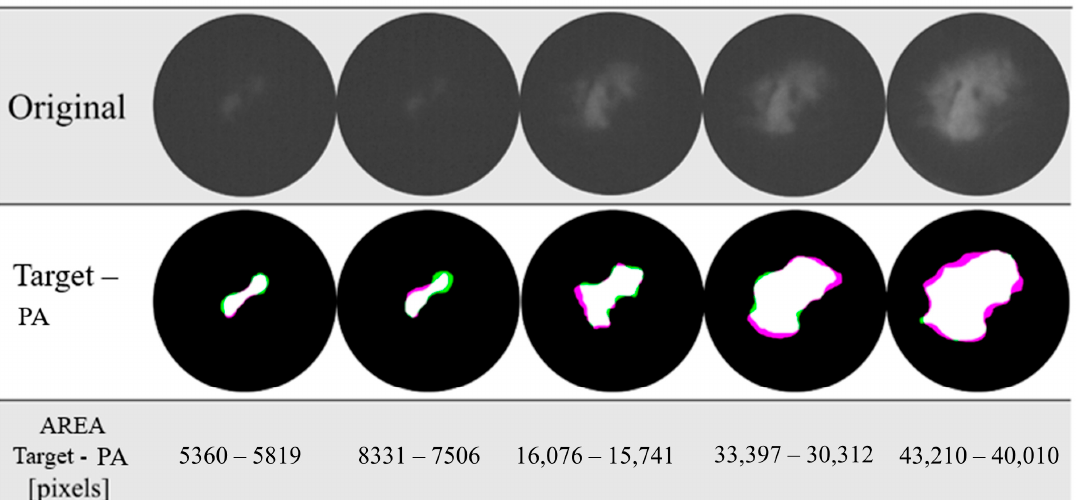
Figure 9. Overlap of the binarized Target images and CNN ones and quantification of the corre- sponding equivalent flame area. The overestimation is indicated by green flame area whereas the underestimations with violet.